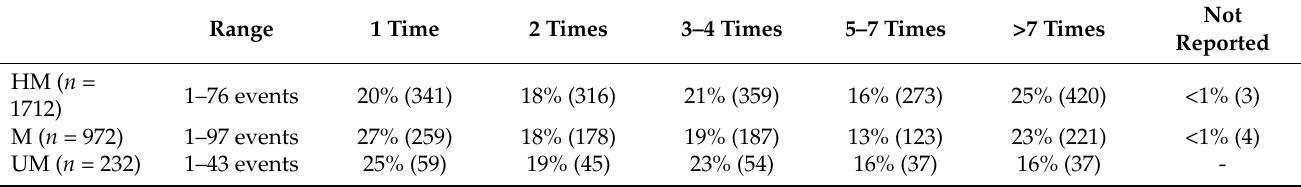
Table 3. Number of half-marathon, marathon, and ultra-marathon competitions completed by runners (as successful participation in the running events) based on numerical categories. Range 1 Time 2 Times 3–4 Times